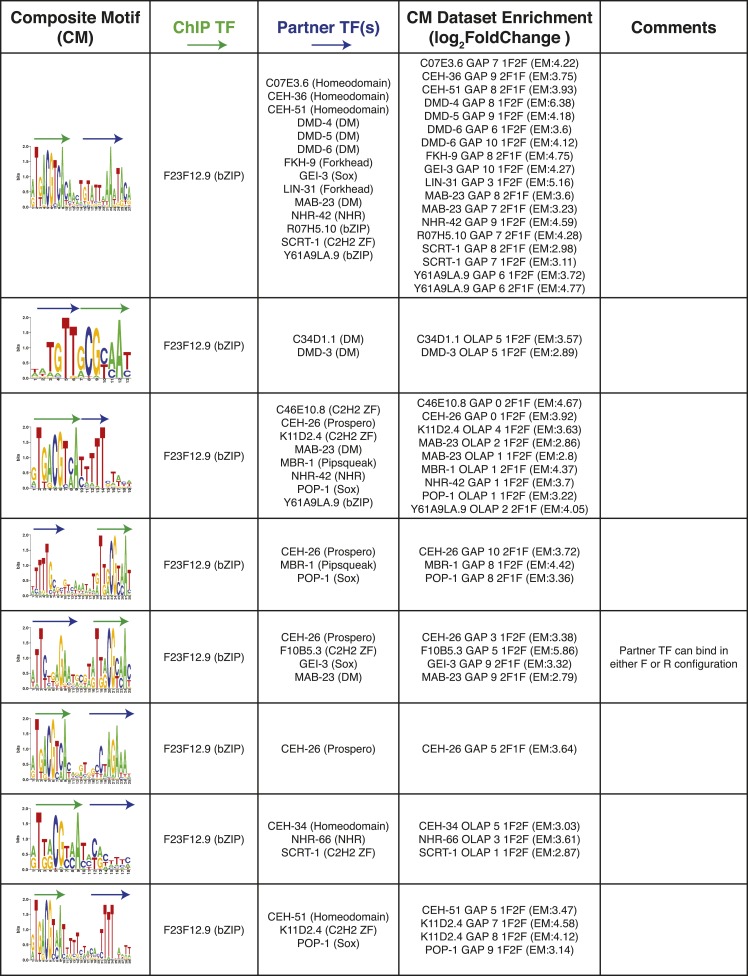
Summary of clustered CMs enriched in C. elegans ChIP-seq peaks (continued).CM-cluster centroids are shown for the enriched motifs. For each cluster, the ChIPed TF(s) and potential partner TF(s) are listed along with information about motif overlap (OLAP), spacing (GAP), and enrichment. Colored arrows over motif indicate high-information content portions of either factor.